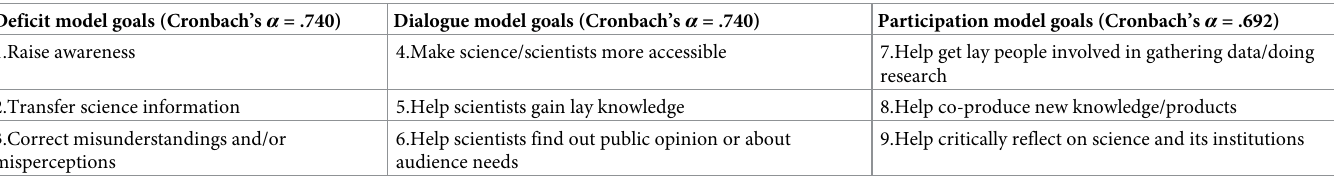
Table 4. Social media science communication goals and models. Deficit model goals (Cronbach’s α =